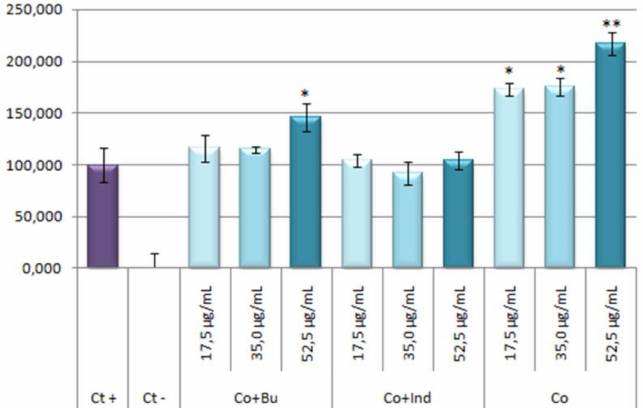
Figure 11. E ff ect of Co and stoichiometric Co-mixtures with bum and ind on the release of nitrites in LPS RAW 264.7 activated macrophage murine cells. The stoichiometric mixtures were incubated for 24 h at concentrations of 17.5, 35.0, 52.5 µ g / mL. The data represent the mean ± S.D. of at least two independent experiments performed in triplicate. Key: p < 0.1 (*), p ≤ 0.01 (**), respect to LPS treated positive control cells.